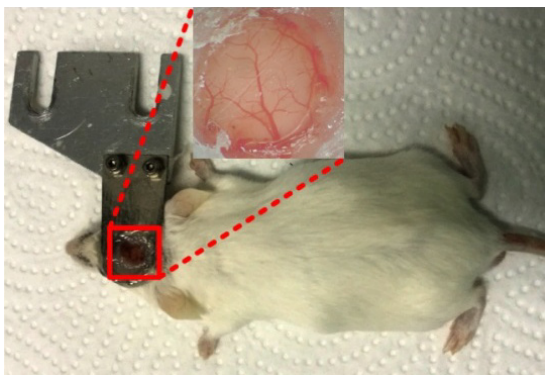
Fig. 1. Model of mouse